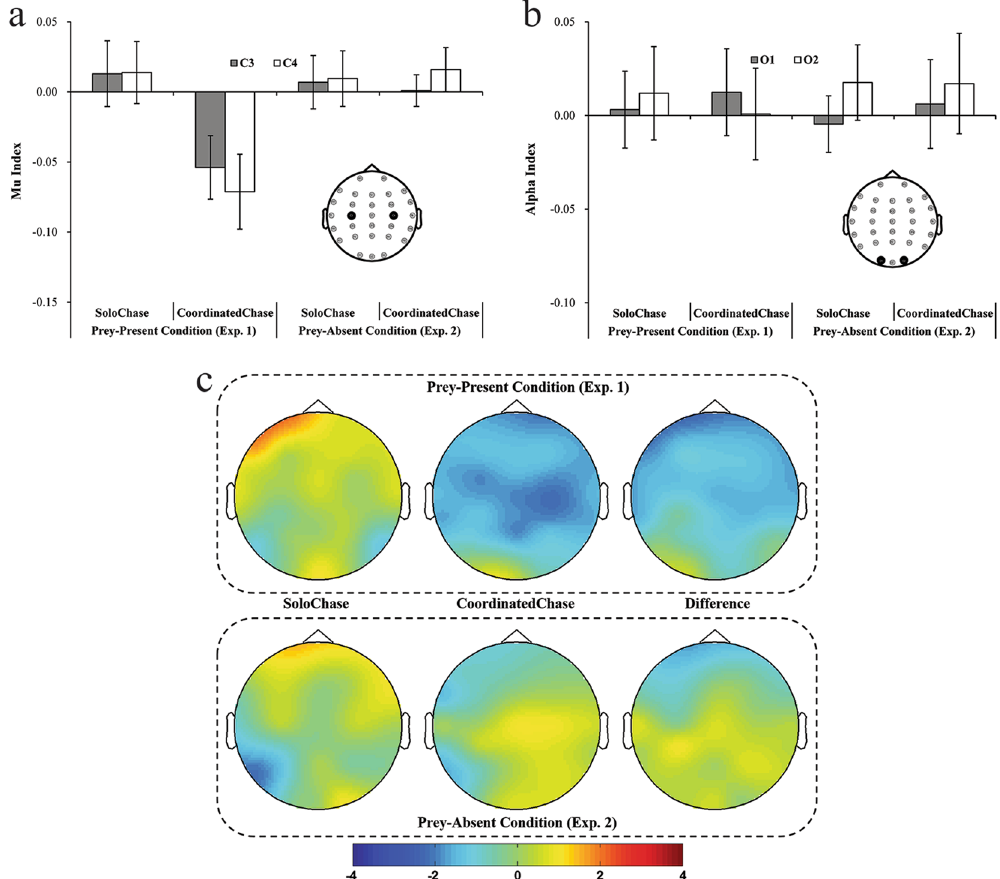
Figure 3. EEG results when watching different kinds of chasing actions. ( a ) and ( b ) Show the patterns of Mu index and Alpha index, respectively. ( c ) Depicts topographic representations for t- tests against zero of each condition and for t-tests for differences between both conditions (i.e., the coordinated chase condition relative to the solo chase condition). The color in ( c ) represents t-tests values against zero in figures of two left columns and t-tests for differences between the coordinated chase condition and the solo chase condition in figures of one right column. Error bars indicate standard errors ( ± SE).